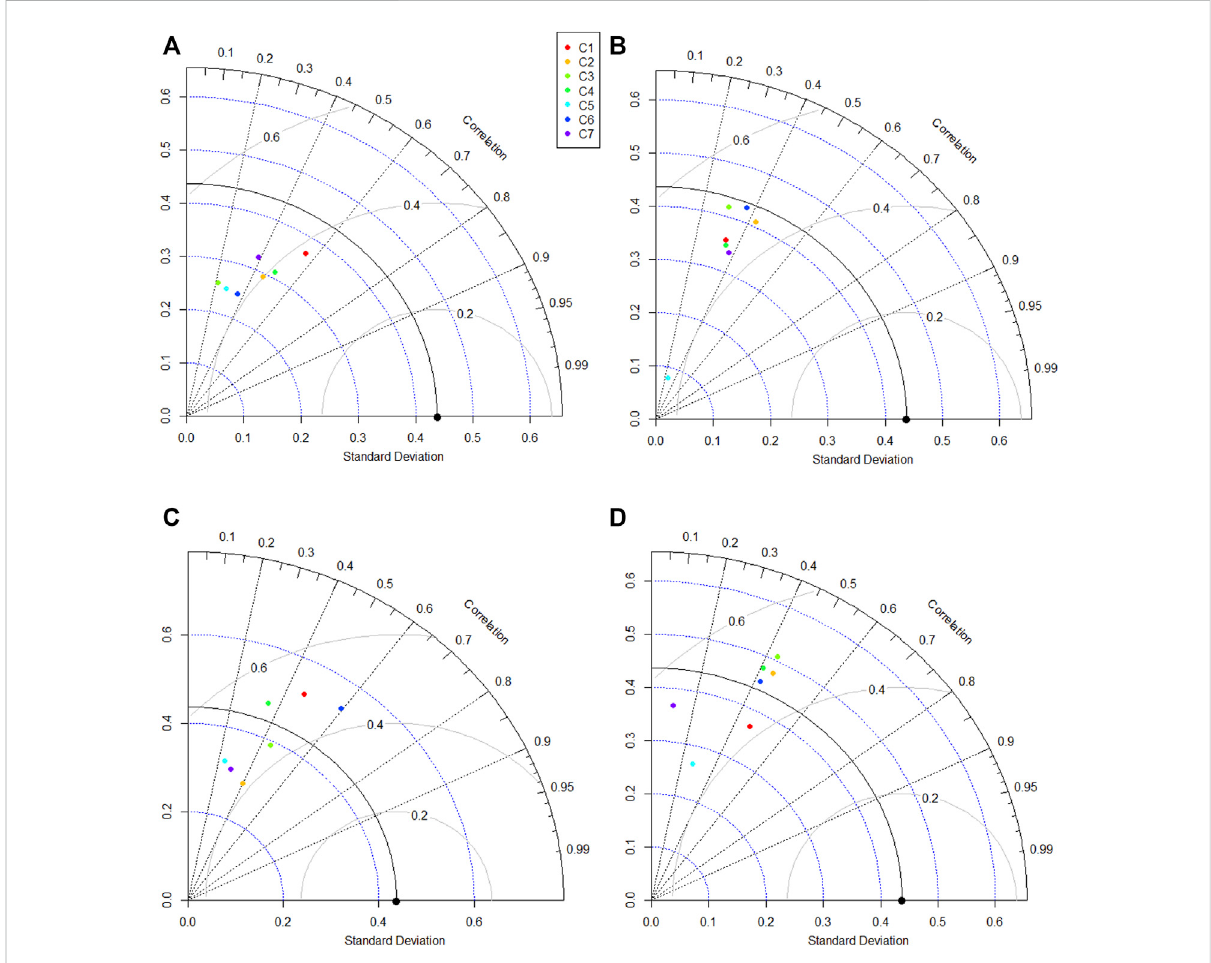
FIGURE 12 Taylordiagramofthemodelsusedto comparethecapabilityof (A) NF-GWO; (B) NF; (C) NF-SC;and (D) NF-FCMmodelsinthetestingphaseat